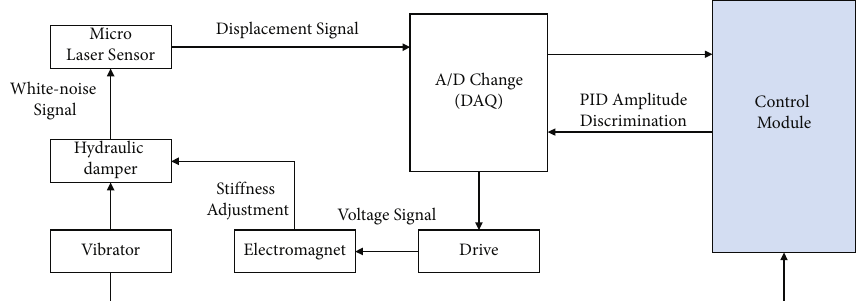
Figure 17: Control program block